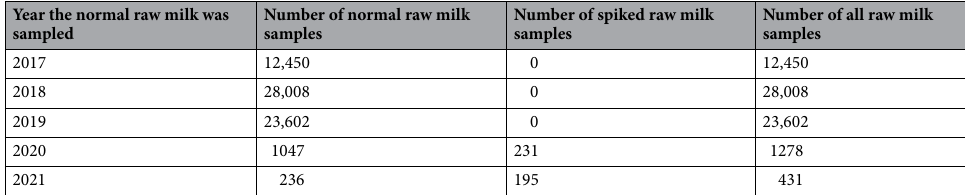
Table 6. Number of normal raw milk samples and the year of